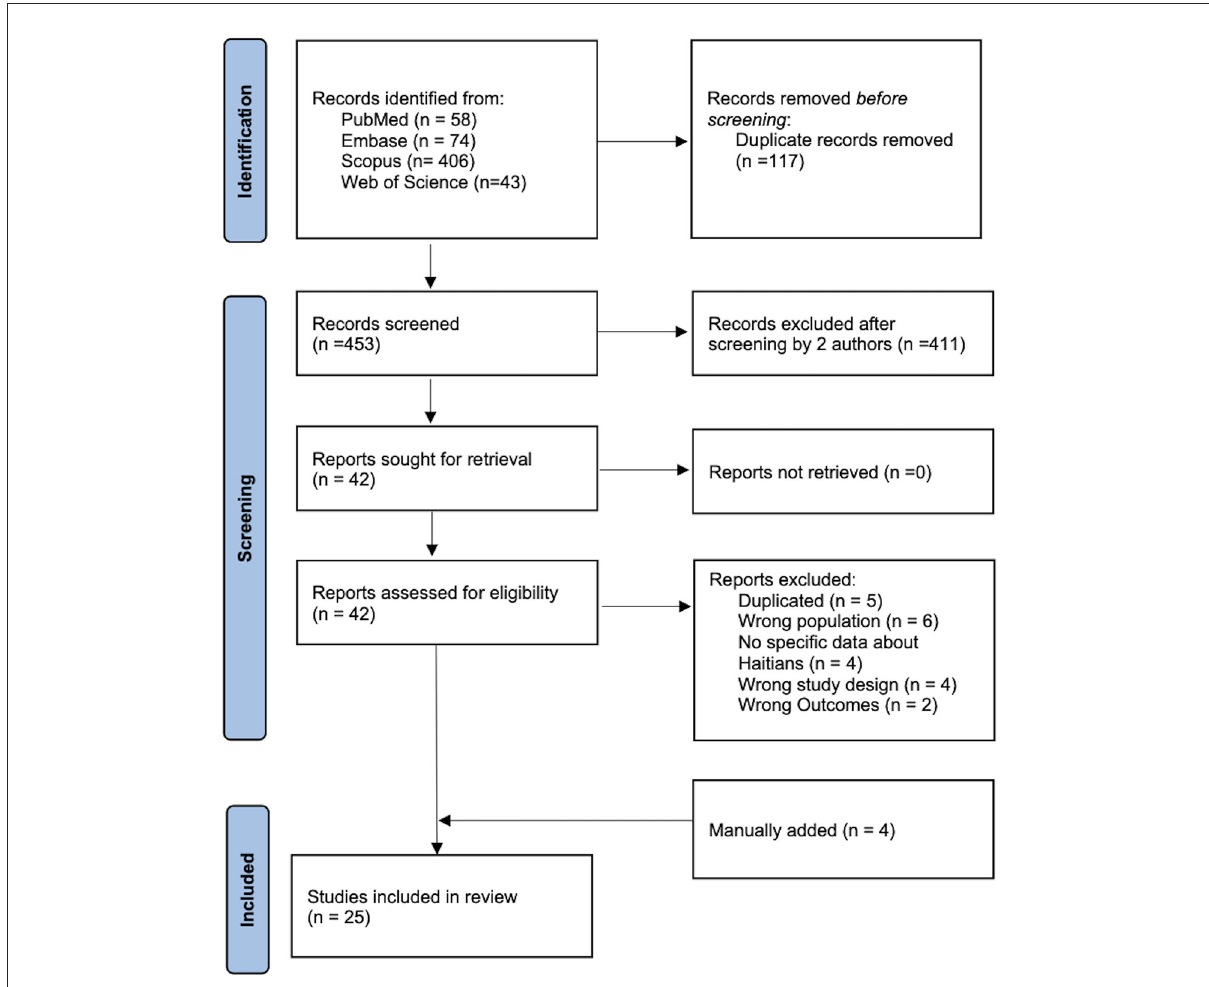
FIGURE1 PRISMA flow diagram showing the study selection process.